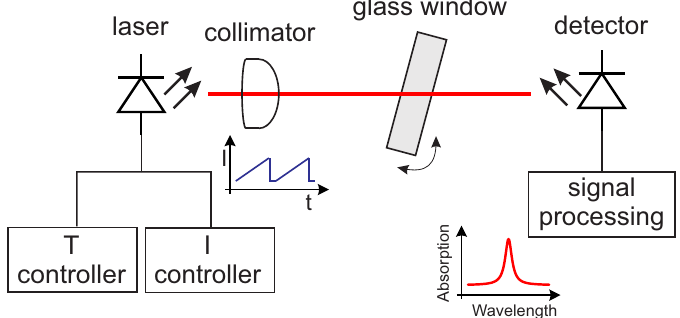
Figure 7. Schematic diagram of the setup used for the absorption spectroscopy